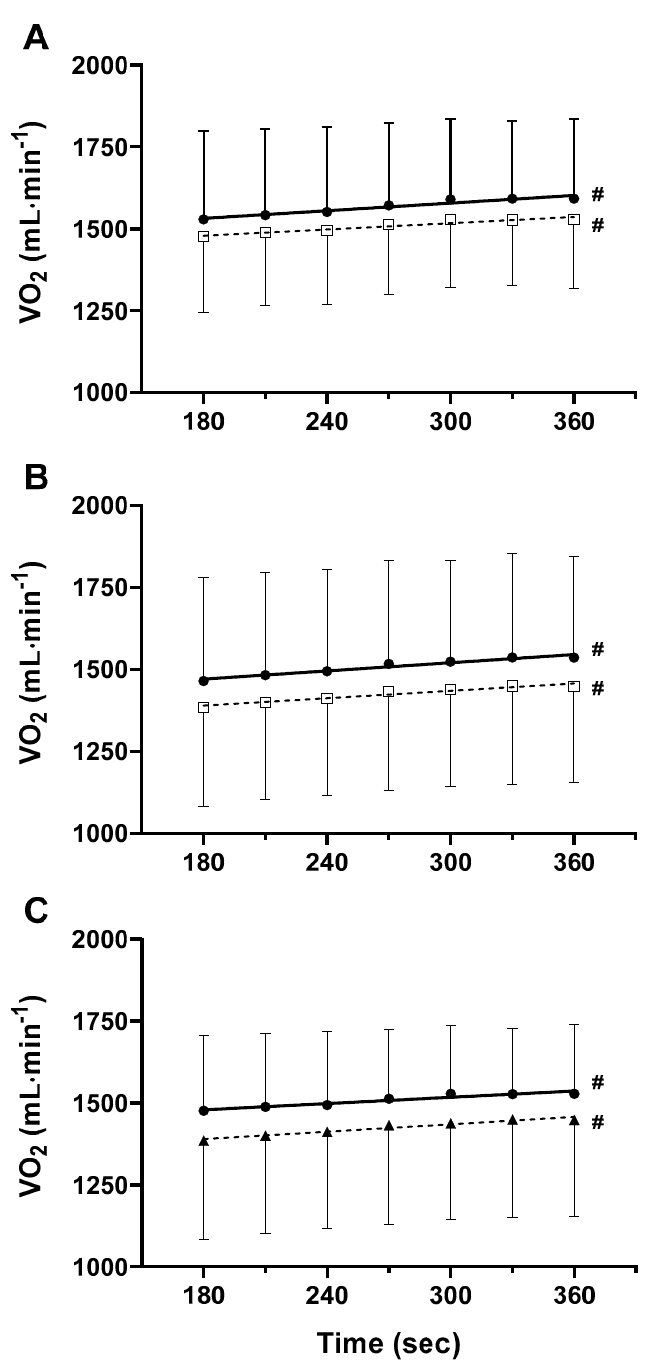
Figure 2. 𝑉(cid:4662) O 2 vs. time from the 3rd to the 6th min of exercise during DL-HVY. Data in ( A ) show the relationship between the 𝑉(cid:4662) O 2p diminished by the estimated O 2 cost of breathing (white squares) and the gross 𝑉(cid:4662) O 2 (black circle) vs. time SL-ET GRP after training. Data in ( B ) show the same relationship as in ( A ), but in DL-ET GRP . Data in ( C ) refers to the linear increase of 𝑉(cid:4662) O 2p subtracted by the estimated O 2 cost of breathing for SL-ET GRP (black circles) compared to DL-ET GRP (black triangle). Data are expressed as mean ± standard deviation. #: angular coefficient of the regression line is significantly different from zero. . V O 2p at the last min of DL-HVY decreased by 4.1% ± 5 ( p = 0.012) and by 6.3% ± 7.5 ( p = 0.001) in SL-ET GRP and DL-ET GRP , respectively; there was no difference between